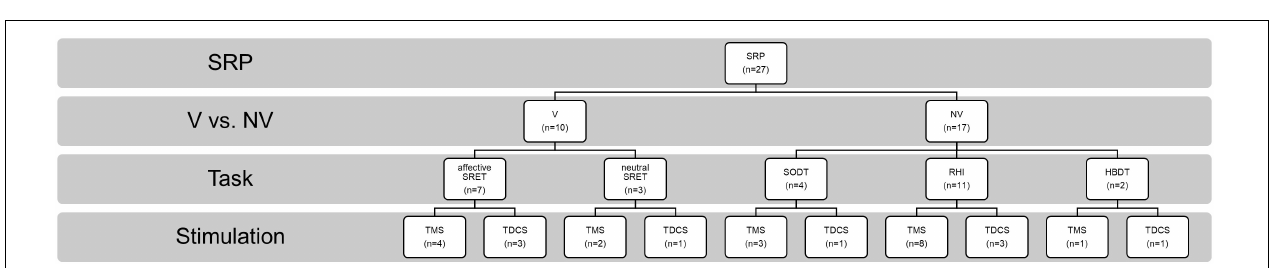
FIGURE 2 | Summary of the included studies by type, task, and stimulation modality. SRP, self-referential processing; V, verbal SRP; NV, non-verbal SRP; SRET, self-referential encoding task; SPE, self-processing effect; SODT, self-other discrimination task; RHI, rubber hand illusion; HBDT, heartbeat detection